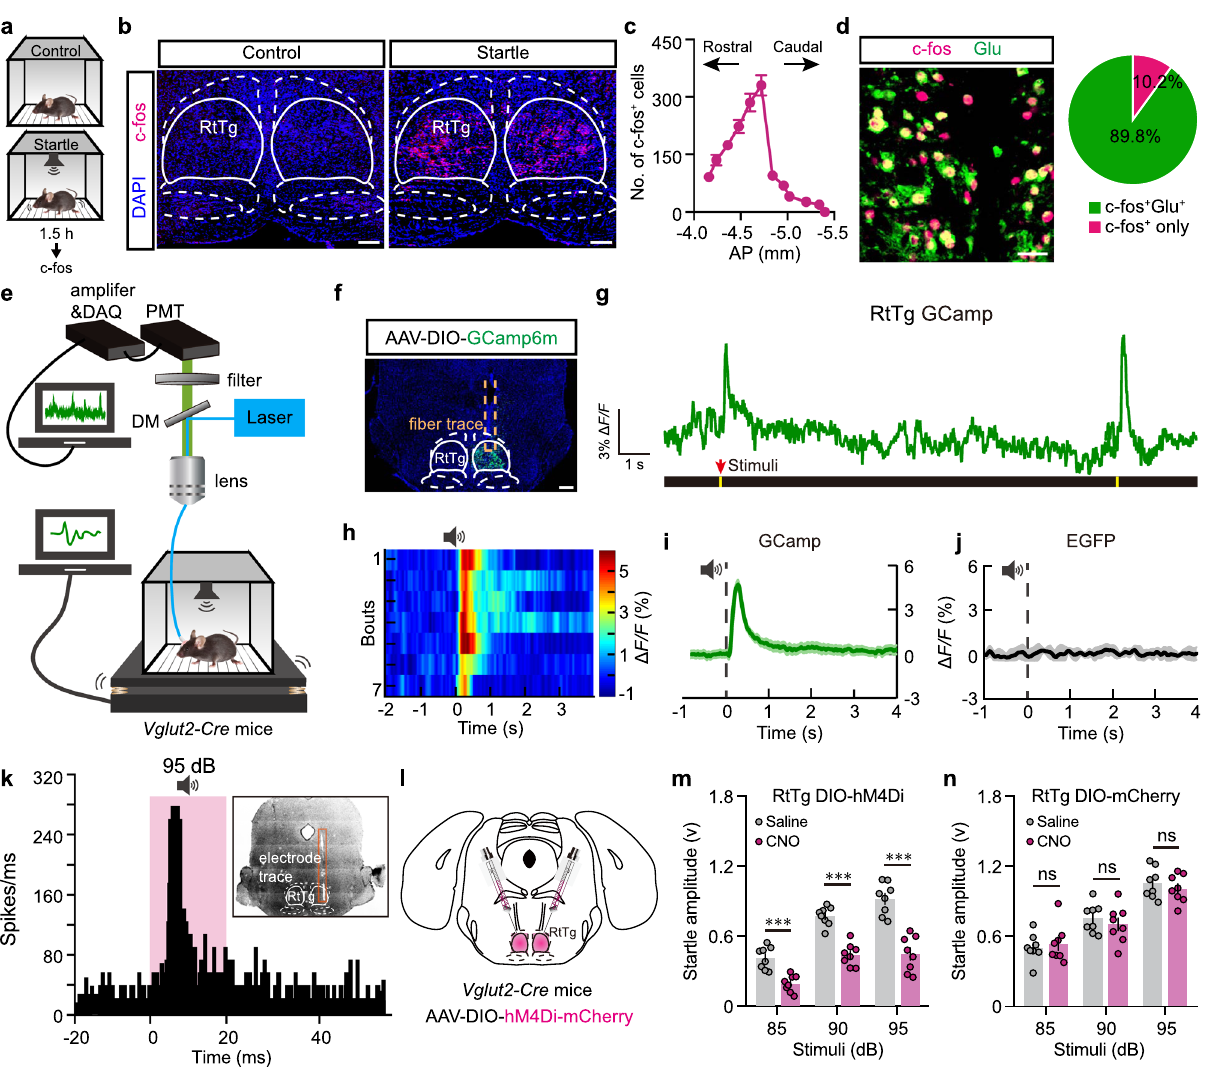
stimuli-induced c-fos expression in the RtTg. Scale bar, 200 μ m. c Quanti fi cation of the c-fos + cell number in consecutive RtTg sections ( n = 6 mice). AP, distance anterior or posterior to Bregma. d Left: a representative image showing RtTg c-fos + cells co-labelled with glutamate. Scale bar, 50 μ m. Right: pie chart indicating the percentage of c-fos + neurons co-labelled with or without glutamate. e Schematic of fi ber photometry setup. f A representative image con fi rming GCamp6m expression in the RtTg. Scale bar, 400 μ m. g , h Representative traces (g) and heat map (h) of calcium signal changes of RtTg glutamatergic neurons aligned to the acoustic stimuli onset. i , j Quanti fi cations of calcium ( i , n = 35 bouts from 5 mice) and EGFP ( j , n = 25 bouts from 5 color indicates s.e.m. k The average peristimulus time histogram showing RtTg neuronal activities evoked by acoustic stimulus. l Schematic